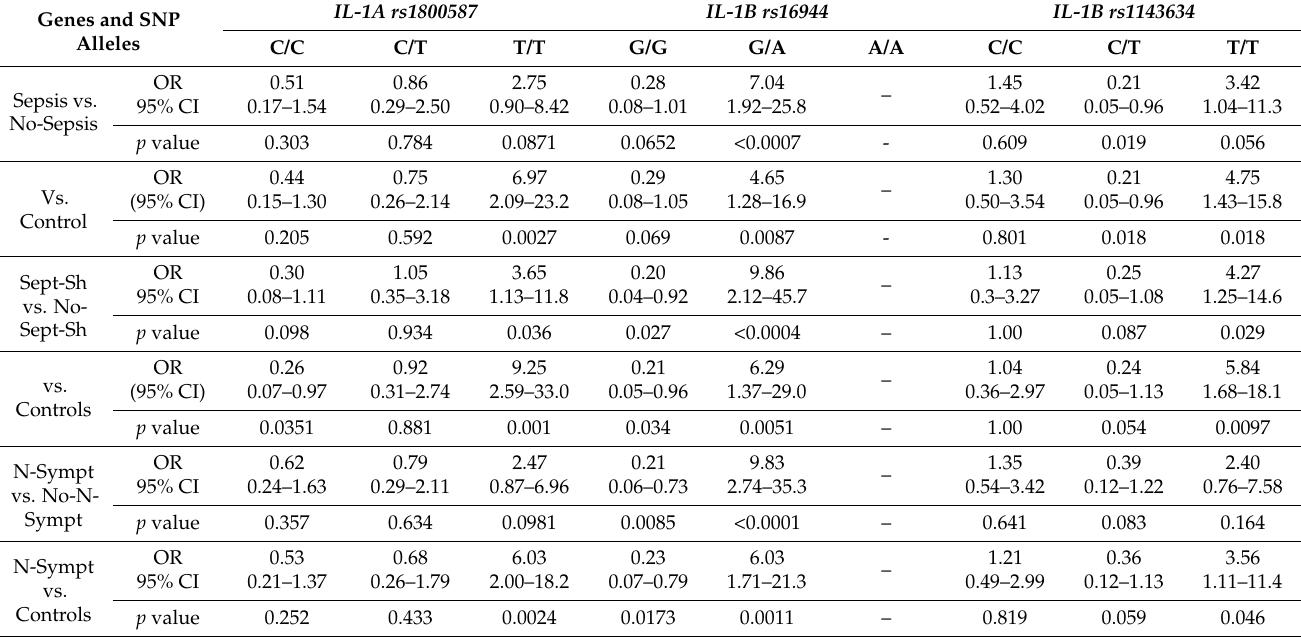
Table 7. Association of IL-1A rs1800587 , IL-1B rs16944 and IL-1B rs1143634 genotypes (odds ratio: OR, 95% confidence interval: 95% CI, significance: p ) with the presence of neurological symptoms (Neu-Sympt, 21 patients), sepsis (17 patients), Sepsis shock (Sept-Sh, 15 patients) or coma (8 patients) in the complicated MSF patient group compared with the uncomplicated patient group and